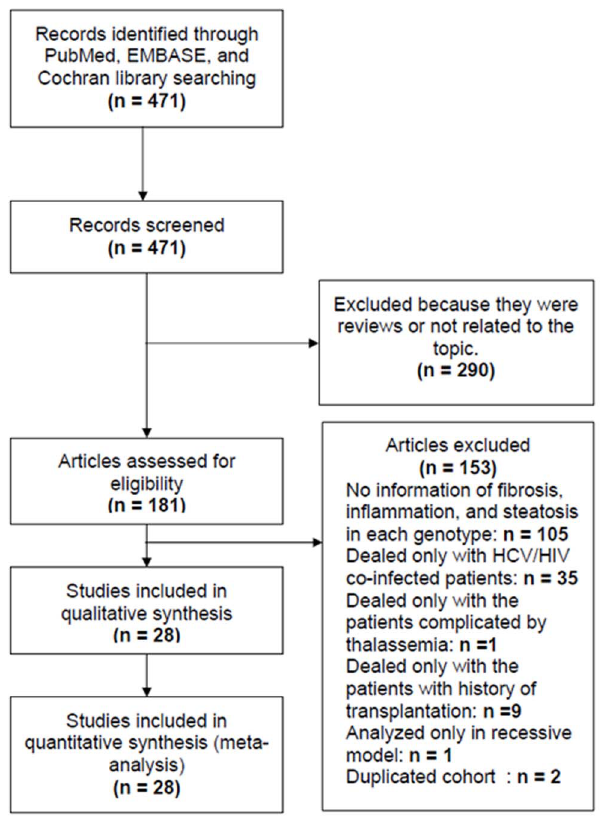
Figure 1. Literature search and study selection process. Twenty- eight individual studies that met all of the inclusion and exclusion criteria.